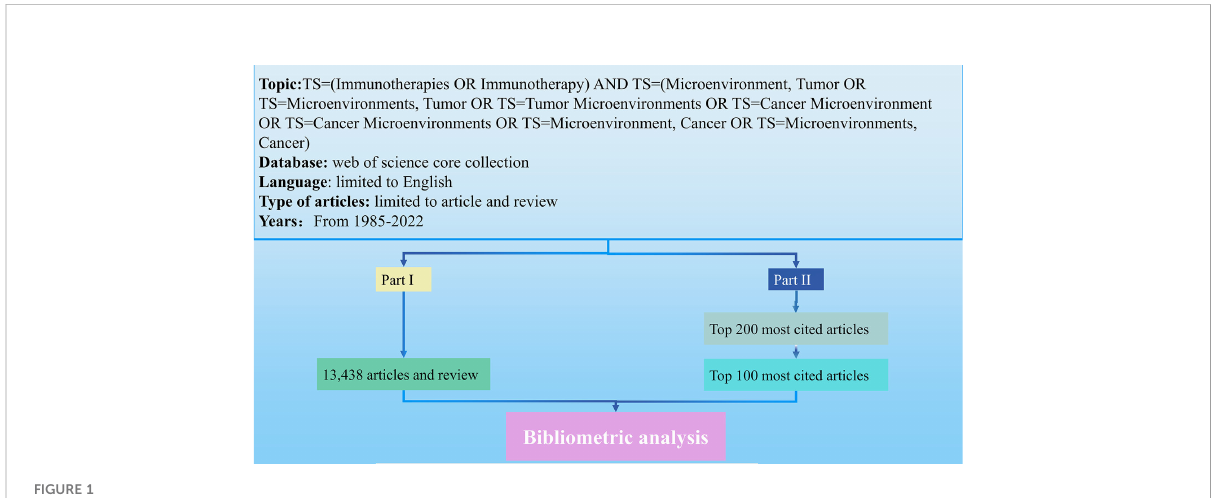
FIGURE 1 Flow chart of the whole